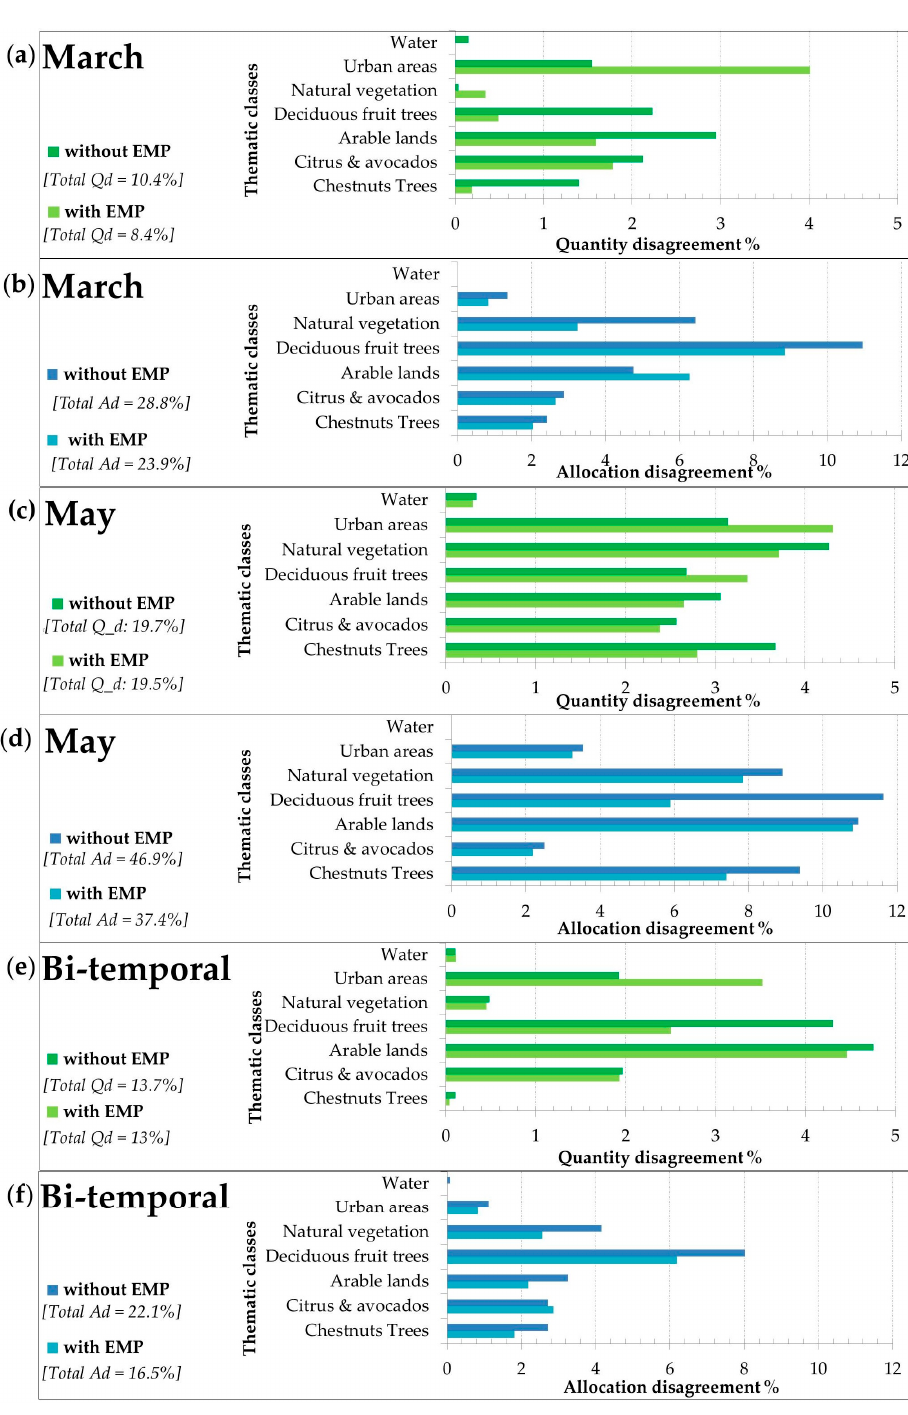
Figure 5. ( a ) March and March_EMP Qd (%). ( b ) March and March_EMP Ad (%). ( c ) May and May_EMP Qd (%). ( d ) May and May_EMP Ad (%). ( e ) Bi-temporal and Bi-temporal_EMP Qd (%). ( f ) Bi-temporal and Bi-temporal_EMP Ad (%).